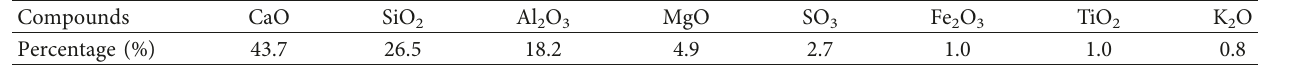
Table 1: The main chemical composition of the